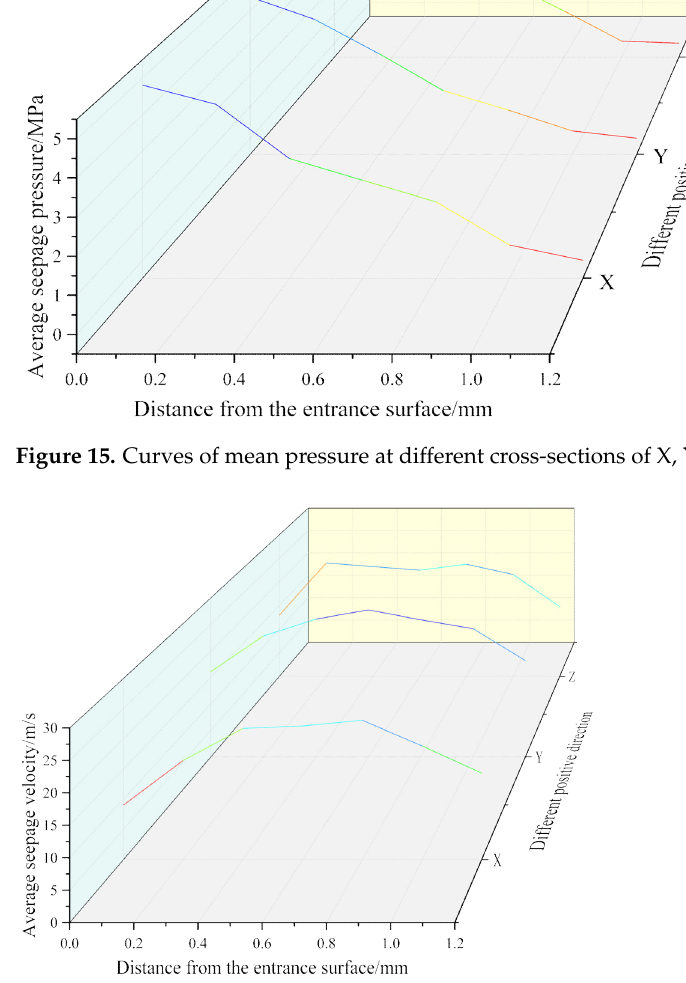
Figure 16. Curves of average seepage velocity at different cross-sections of X, Y, and Z seepage.